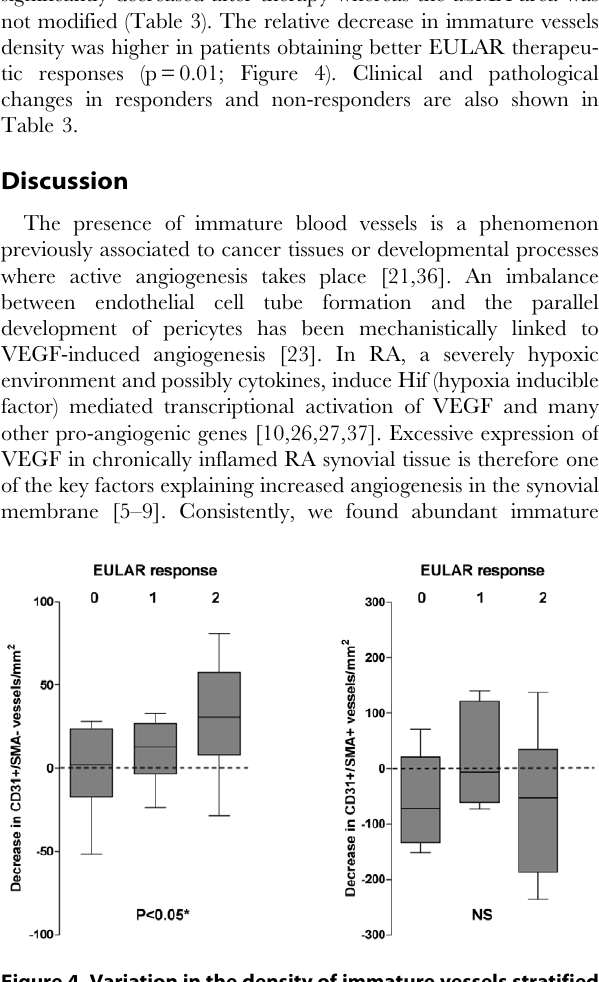
Figure 4. Variation in the density of immature vessels stratified by the levels of response to anti-TNF- a therapy. Decrease in immature (left graphics) or mature (right graphics) vessels density between the first and second biopsy after anti-TNF- a therapy is shown stratified by EULAR responses: 0=: No response; 1: Moderate response; 2: Good response. (*) Kruskall Wallys test and post hoc Dunns test (non- responders versus good responders).